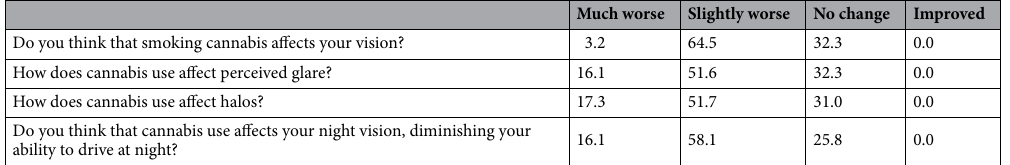
Table 2. Participants’ self-perceived changes in visual quality after using cannabis. The data is expressed in percentages.